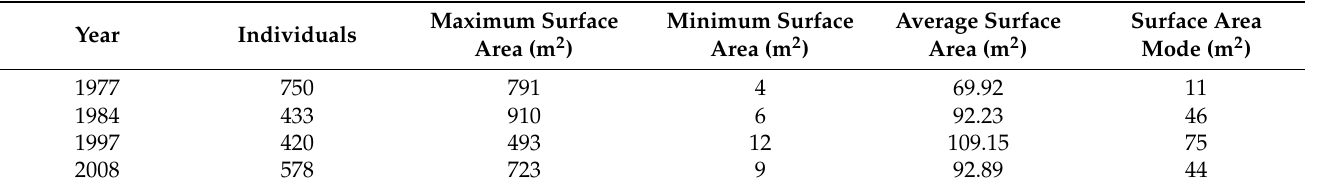
Table 8. Characteristics of the population for each evaluated date.